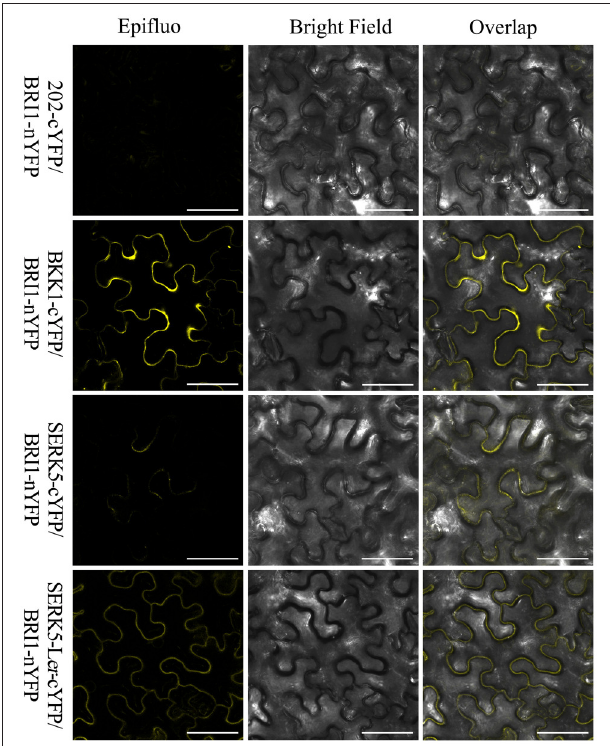
FIGURE 9 | BiFC assay to show the association of BRI1 and SERK5-L er in planta . BRI1-nYFP was co-expressed with SERK5-L er -cYFP, BKK1-cYFP, and SERK5-cYFP in epidermal cells of Nicotiana benthamiana . Representative confocal images showing the YFP fluorescence signal indicate the physical interaction between BRI1 and SERK5-L er , BKK1, SERK5 at plasma membrane. BKK1 and SERK5-L er strongly interact with BRI1, while SERK5 only shows very weak binding with BRI1. Co-expression of 202-cYFP and BRI1-nYFP was used as a negative control. Similar results were obtained in more than three replicates. Scale bars = 50 µ